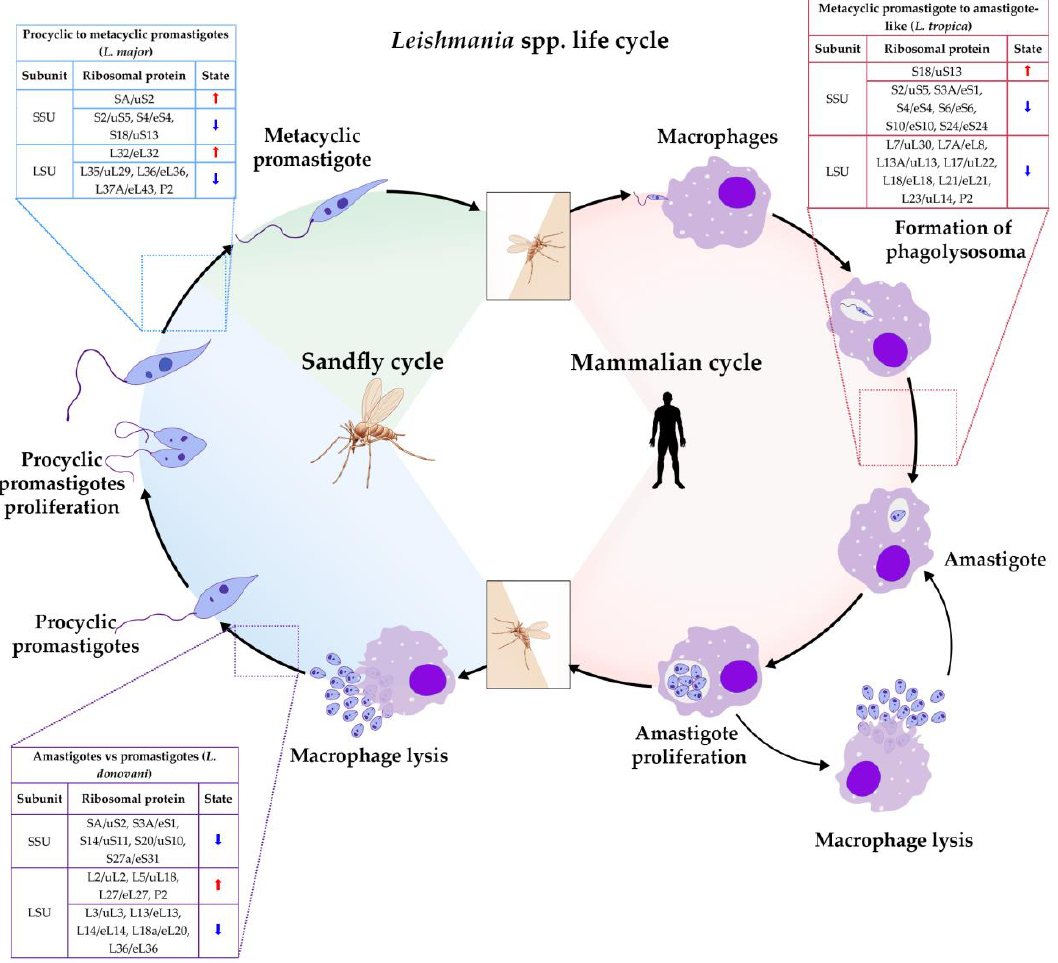
Figure 5. Ribosomal proteins (RP) developmentally regulated in Leishmania . Tables show up-regulated ( ⬆ ) and down-regulated ( ⬇ ) RPs from SSU and LSU. The blue Table illustrates RPs regulated in the differentiation of L. major from procyclic to metacyclic promastigotes [112]. The light red Table includes RPs regulated in the differentiation of L. tropica from metacyclic promastigotes to amastigotes-like [113]. The purple table shows RPs differentially expressed in amastigotes compared to promastigotes of L. donovani [114].